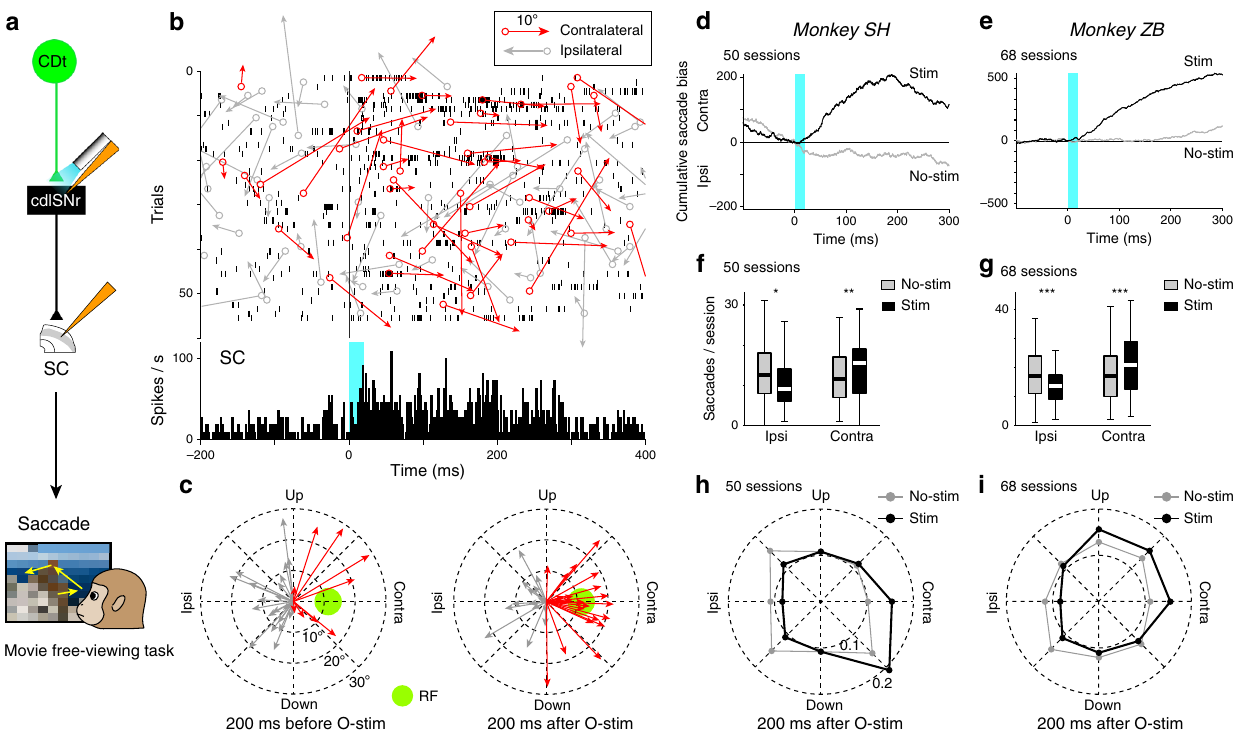
Fig. 6 Facilitation of contralateral saccade by optical stimulation to CDt-SNr pathway. a Eye movements before and after optical stimulation were examined in the movie free-viewing task. b Effects of optical stimulation on SC neuronal activity and saccades. Activity of an SC neuron is shown by raster (top) and spike density function (bottom) (same data as Fig. 5c). Red and gray arrows indicate contralateral and ipsilateral saccades. Angle and length of arrows show direction and amplitude. Each open circle shows the saccade onset along the raster. c Saccade directions in 200 ms before (left) vs. after (right) the stimulation (same data in Fig. 6b). Red and gray arrows show contralateral and ipsilateral saccades, respectively. Light-green circle shows the SC neuron ’ s visual receptive fi eld. d Temporal dynamics of saccade bias in monkey SH (total 50 sessions). Black and gray curves indicate the cumulative saccade bias in stimulation trials (Stim) vs. no-stimulation trials (No-stim). Light-blue shade indicates the stimulation period. e Temporal dynamics of saccade bias in monkey ZB (total 68 sessions). f Number of saccades per session in 200 ms after no-stimulation (gray) vs. stimulation (black) in monkey SH. Ipsilateral saccades per session after the stimulation signi fi cantly decreased ( n = 50, P = 0.024, Wilcoxon singed-rank test, two-sided), whereas contralateral saccades signi fi cantly increased ( n = 50, P = 0.0015, Wilcoxon singed-rank test, two-sided). The band indicates the median, the box indicates the fi rst and third quartiles and the whiskers indicate ± 1.5 × interquartile range. *, ** indicate P < 0.05, 0.01. g In monkey ZB, ipsilateral saccades after the stimulation signi fi cantly decreased ( n = 68, P = 8.2 × 10 − 7 , Wilcoxon singed-rank test, two-sided), whereas contralateral saccades signi fi cantly increased ( n = 68, P = 5.9 × 10 − 5 , Wilcoxon singed-rank test, two-sided). Same format as Fig. 6f. *** indicates P < 0.001. h Mean saccade directions within 200 ms after no-stimulation (gray) vs. stimulation (black) in monkey SH. i Mean saccade directions in monkey